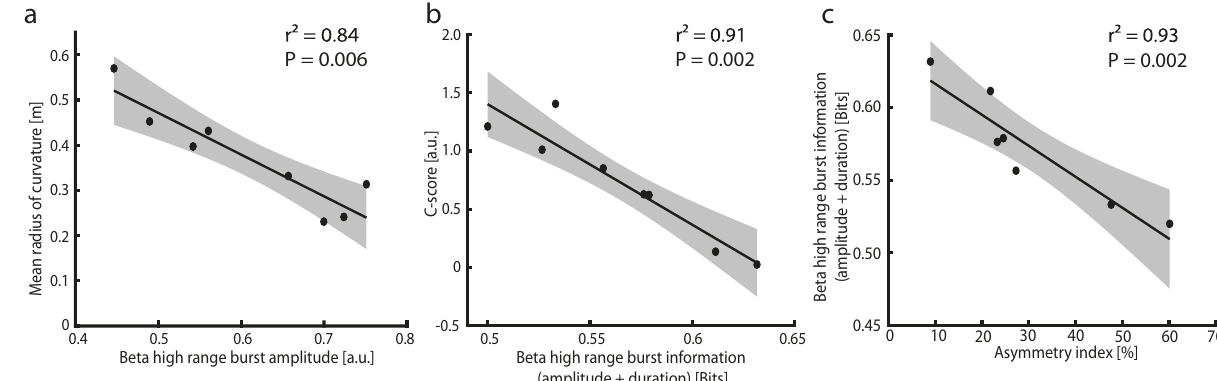
Fig. 4 Correlation between kinematic aspects, burst information, and striatal dopamine reuptake transporter binding. a Correlation between the mean radius of the curvature and the amplitude of the bursts in the beta high range. b Correlation between the inter-joint coordination index ( C -score) and the overall information (amplitude and duration) of the task phases carried by the bursts in the beta high range. c Correlation between the overall information (amplitude and duration) of the task phases carried by the bursts in the beta high range and the inter-hemispheric striatal dopamine loss (asymmetry index). In all panels, a linear regression (black line) is plotted with 95% con fi dence intervals (shaded gray regions). See also Supplementary Fig.